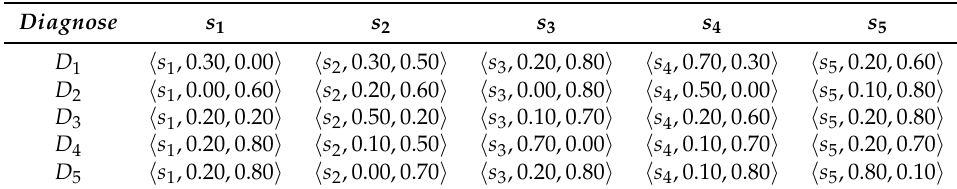
Table 6. The symptoms of the diagnoses in Example 4.